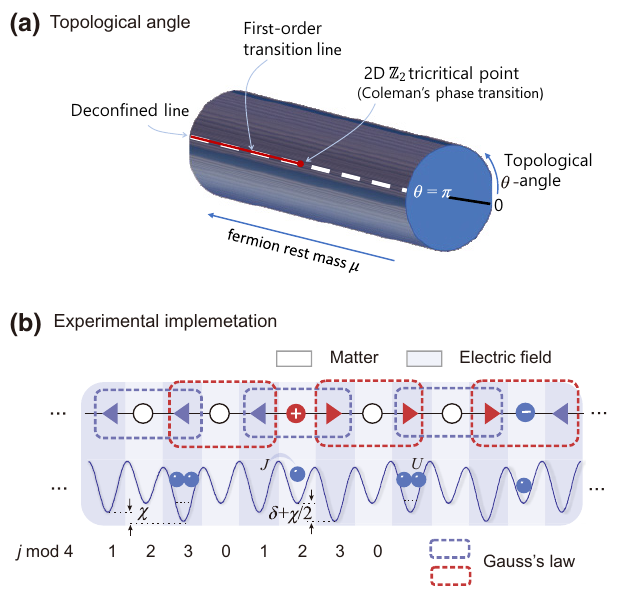
FIG. 1. (a) Topological θ -angle. The ground state of quantum electrodynamics (QED) is periodic under the θ -angle [34,35]. The quantum link model (QLM) formulation of the U ( 1 ) gauge theory loses this periodicity, but retains key features, in particu- lar Coleman’s phase transition and the deconfined line at θ = π . (b) The U ( 1 ) QLM can be implemented in an optical super- lattice with single-species bosonic atoms, where shallow sites are associated to charged matter and deep sites to gauge fields. On-site interaction U , a staggered potential δ , and a tilted poten- tial (cid:5) (not shown) provide energy penalties, which in interplay with nearest-neighbor hopping J generate the desired QLM in second-order degenerate perturbation theory and enforce Gauss’s law on all triple wells centered around a matter site